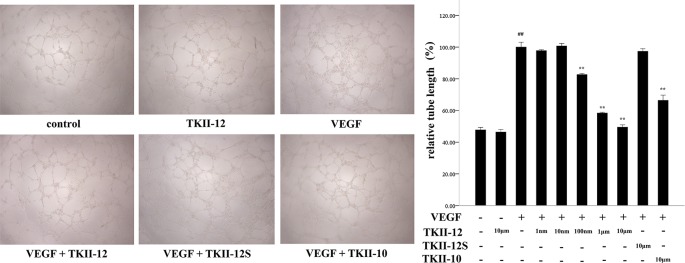
Effects of TKII-12 on vascular endothelial growth factor (VEGF)-induced HRMECs tube formation on Matrigel. The left panel is the representative phase-contrast micrographs of HRMECs exposed to different culture medium at 6 h (magnification 20×). The right panel presents the quantitative graph of the relative percentage of tube length. Each value represents the mean ± SEM of triplicate measurements. **p < 0.01 versus the VEGF group. ##p < 0.01 versus the control group.